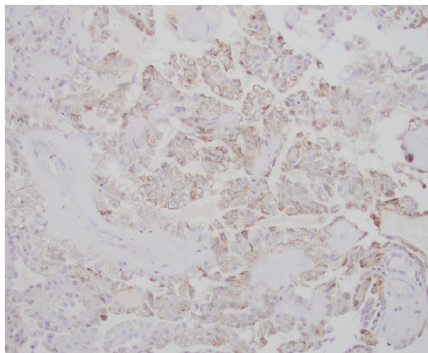
Figure 10: P504S (AMACR) immunostain was focally positive in the tumor cells.